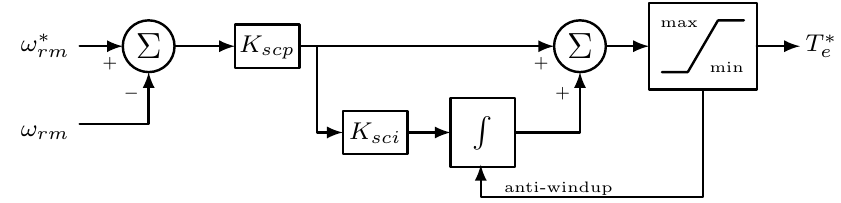
Figure 8. Closed-loop speed control block diagram.